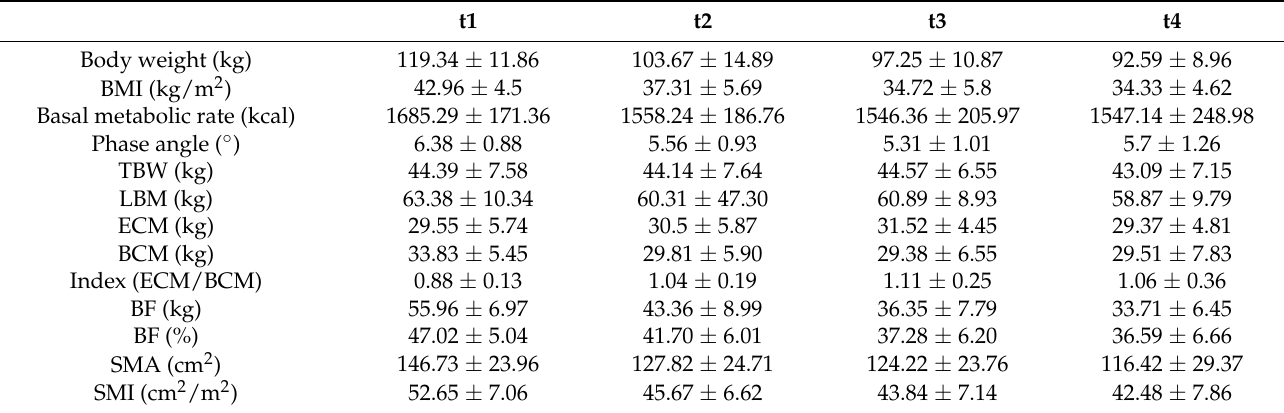
Table 2. Body composition and skeletal muscle index at the different time points.